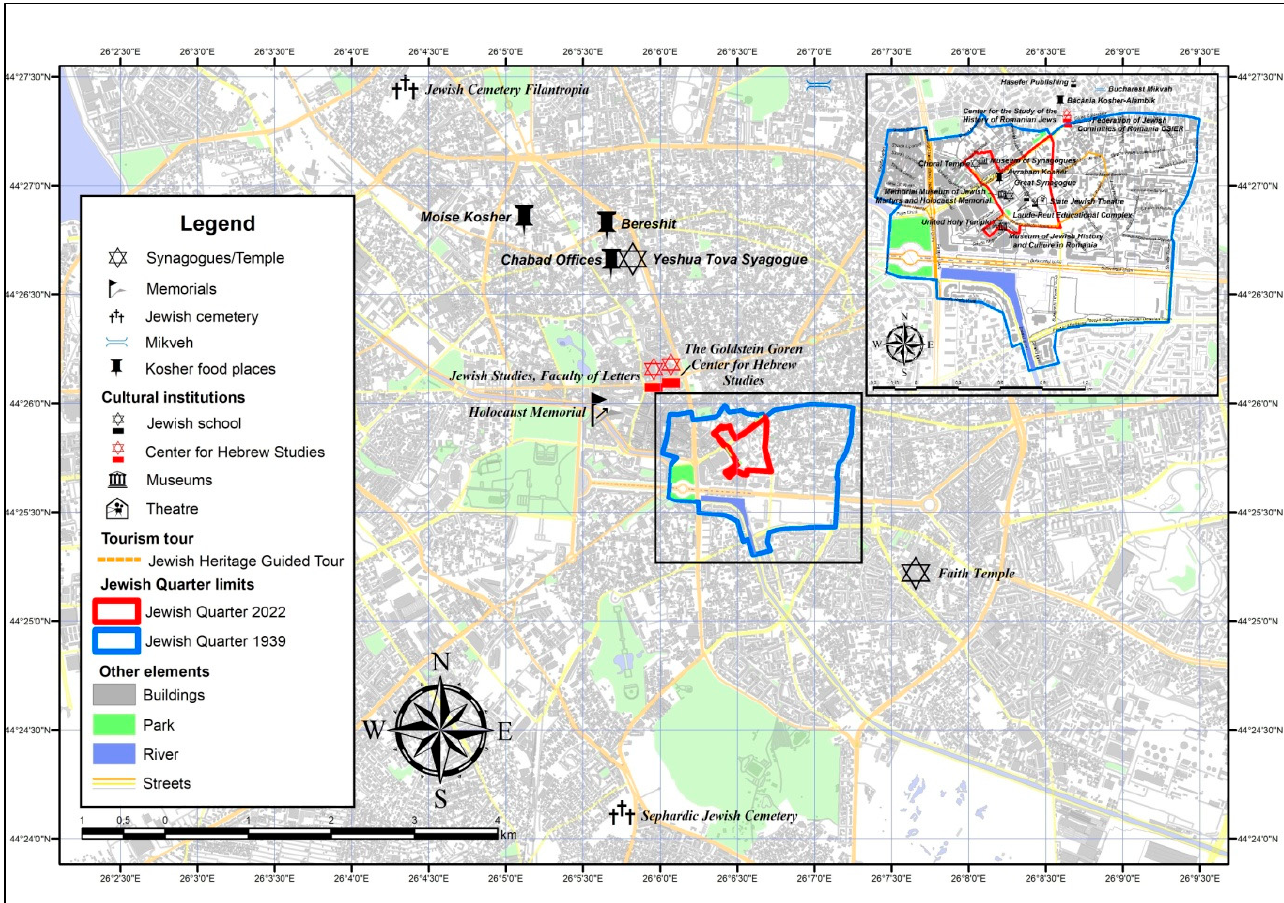
Figure 1. Delimitation of the Jewish Quarter (1939/2022) within the city of Bucharest. Source: au- thor, 2022.